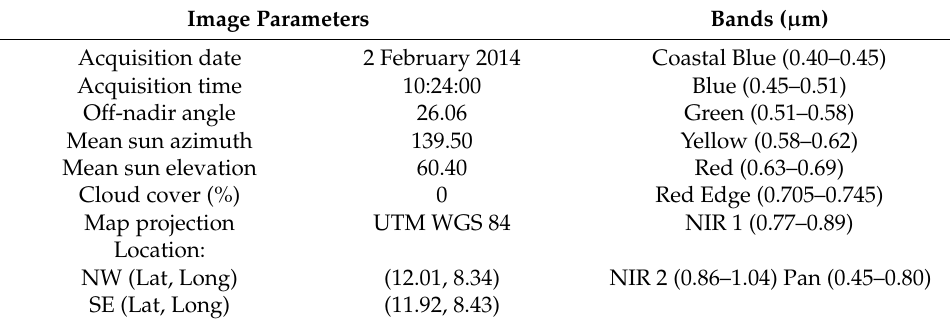
Table 1. Specifications of the WorldView ‐ 2 satellite image.